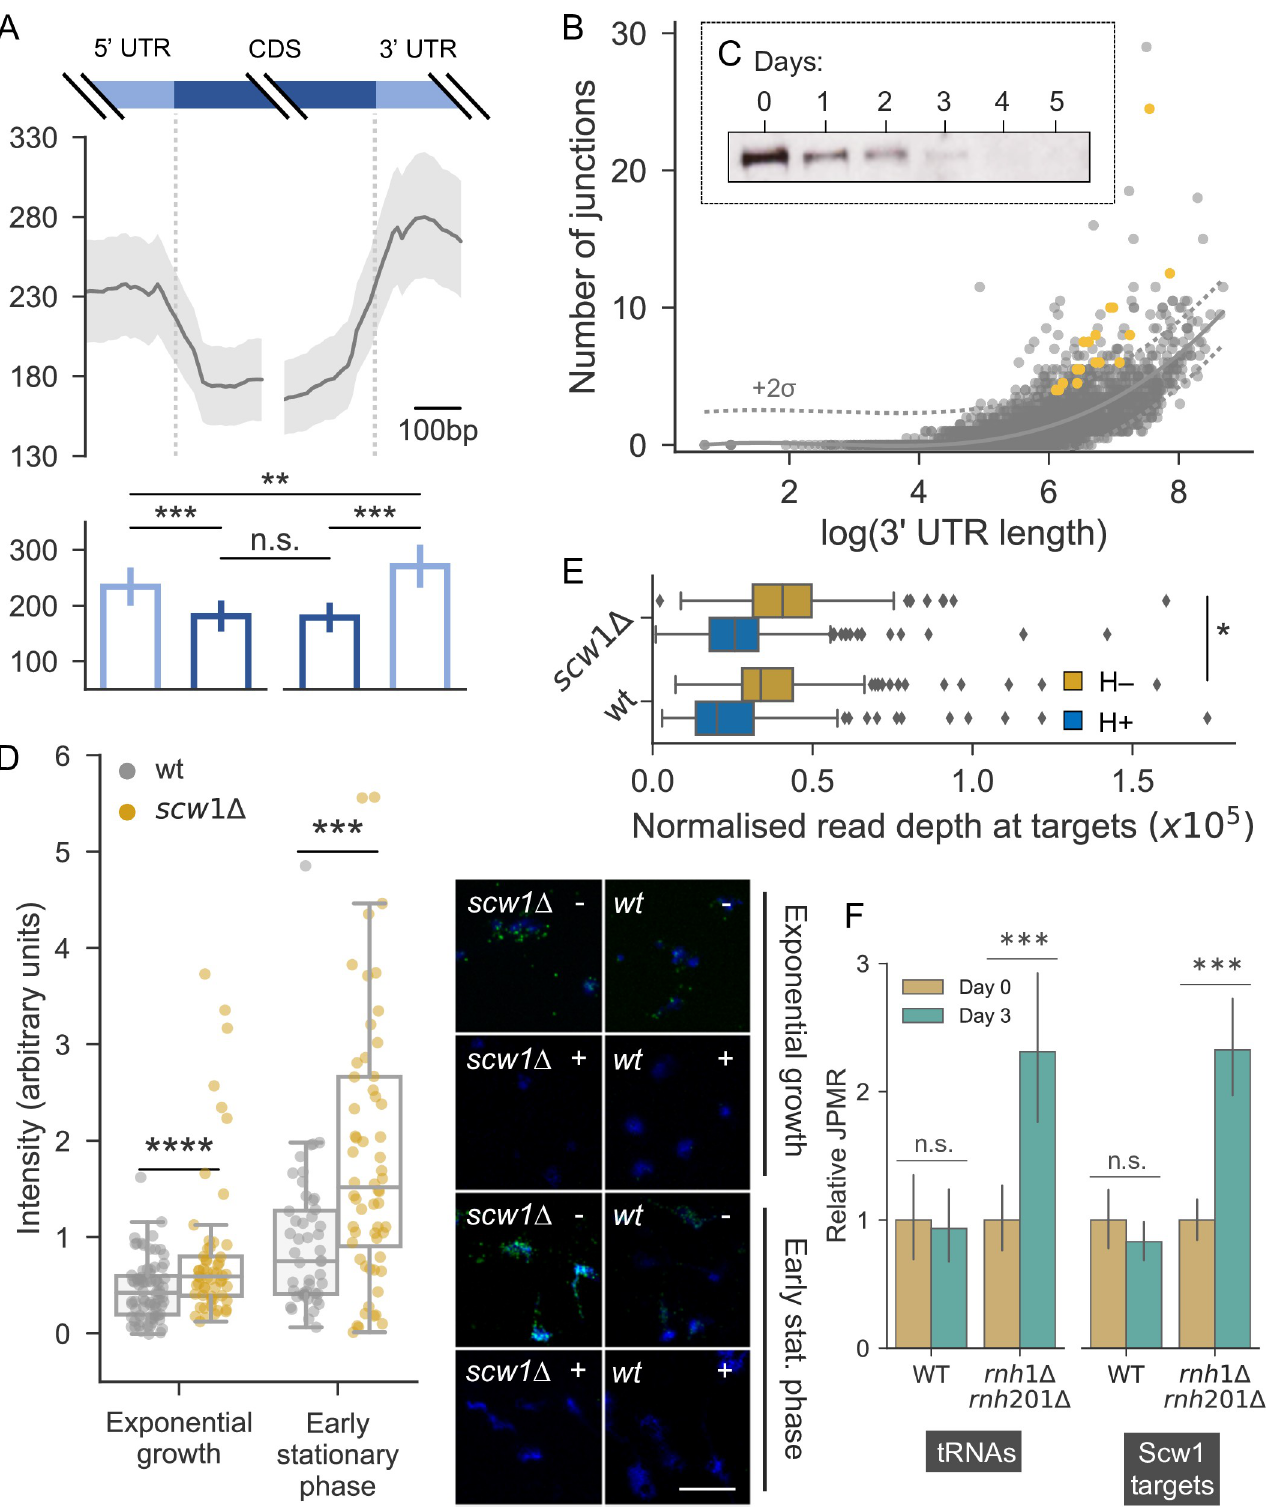
Fig 6. R-loops may contribute to local hotspots in absence of Scw1. (A) Top: sliding mean (10bp windows) junction counts around coding regions (CDS) across genome. Bottom: mean ± standard error of junction counts in 250bp bins on either side of coding regions across genome. Comparisons between bins were performed with paired t-tests ( �� p < 0.001; ��� p < 0.0001; n.s., not significant). (B) Scatter plot of 3’-UTR length vs number of junctions in that UTR. Each